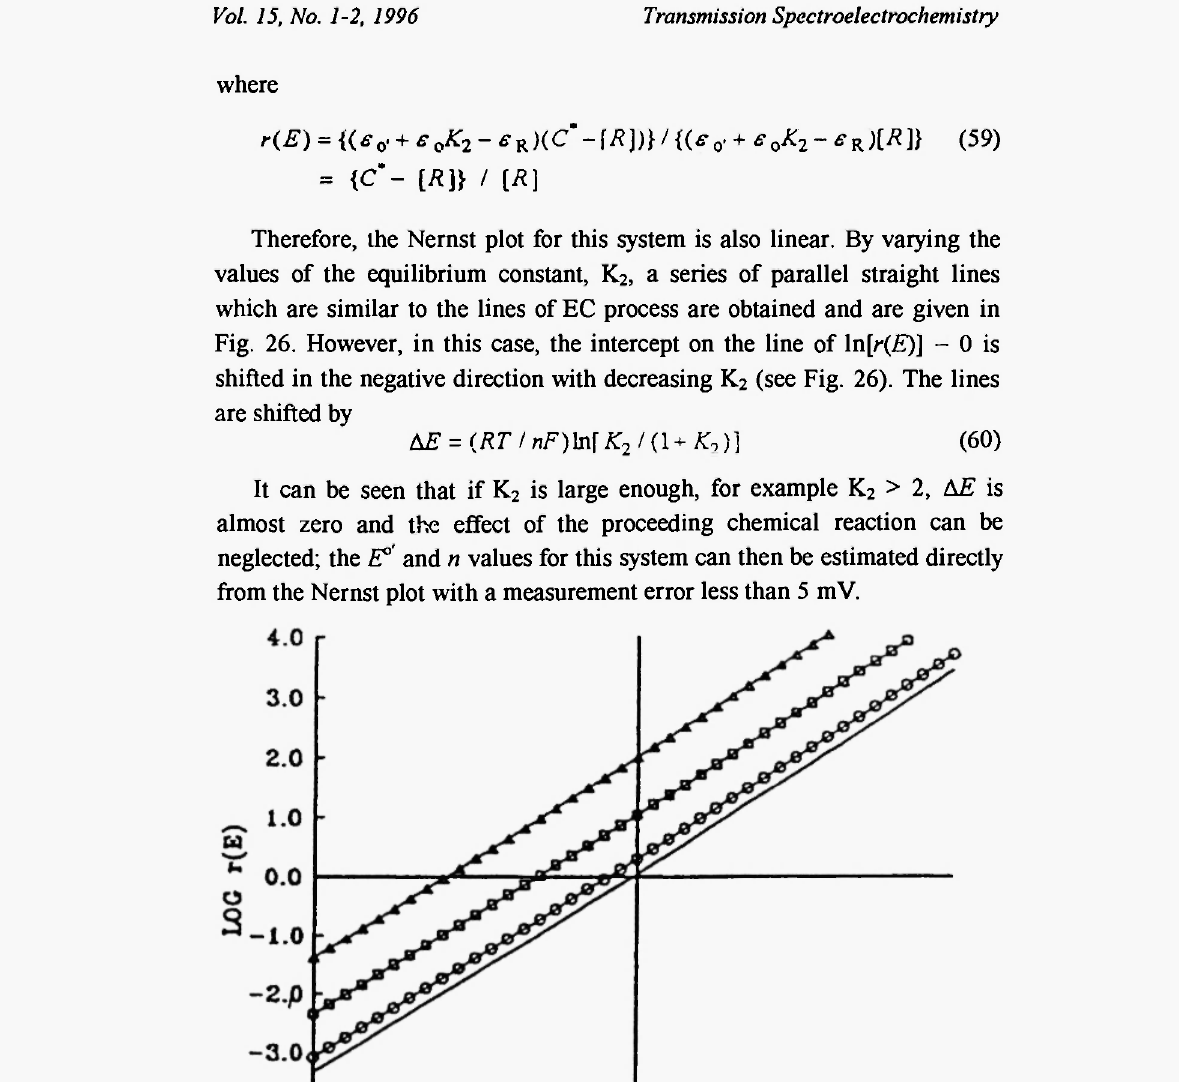
Fig. 26: Nernst plot of an electroreduction process coupled with a proceeding chemical reaction with various equilibrium constants (E° = 0 mV; ε = 1 χ ΙΟ 3 ; ε = ε . = 0; horizontal line, ln[r(E)] = κ 0 κ 0; vertical line Ε = 0): — K = °o, Ο K = 1.0; • K = 0.1; 2 2 2 Δ K = 0.01 (From Ref. 2